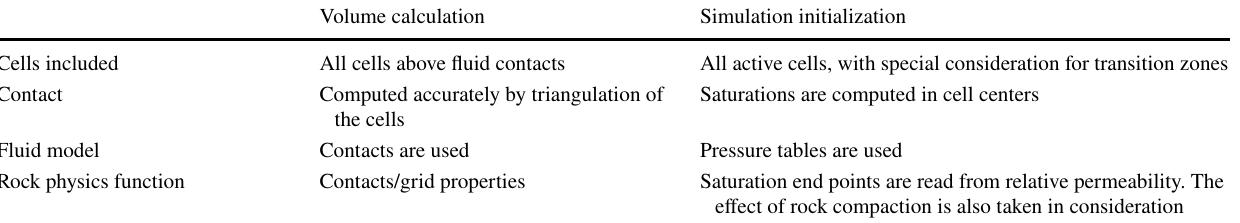
Table 3 Volume calculation versus simulation case initialization (Schlumberger Manual 2014)